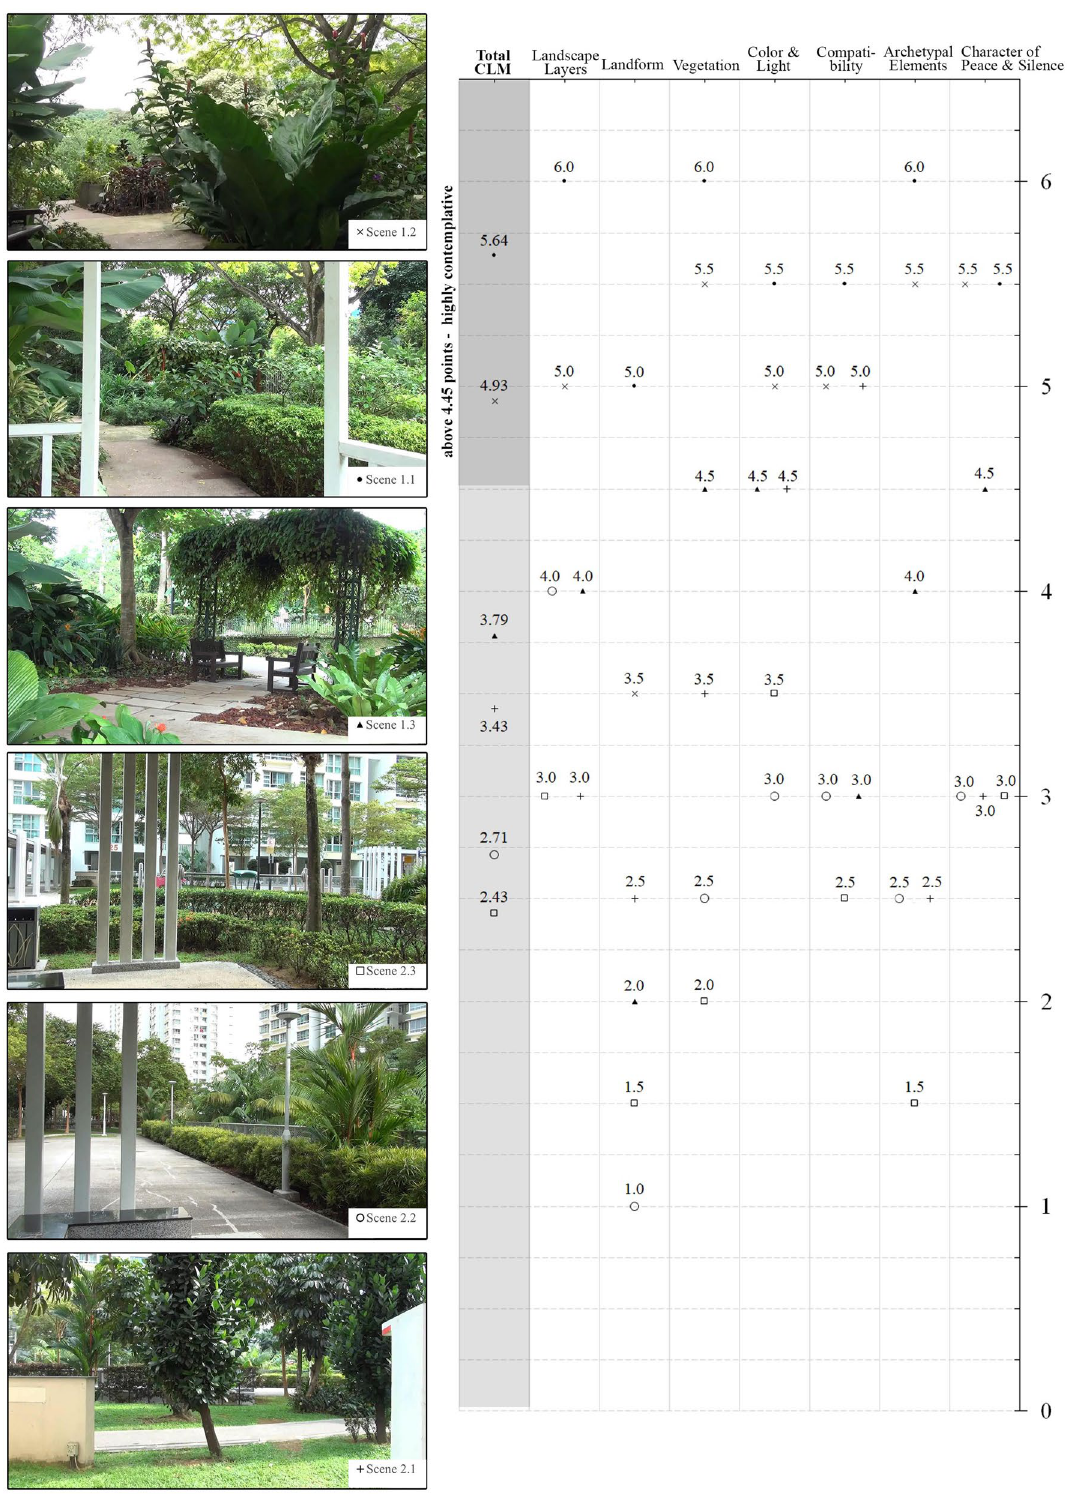
Figure 2. Selected UGS scenes ranking, with CLM scores showing range of different scores (for both total and